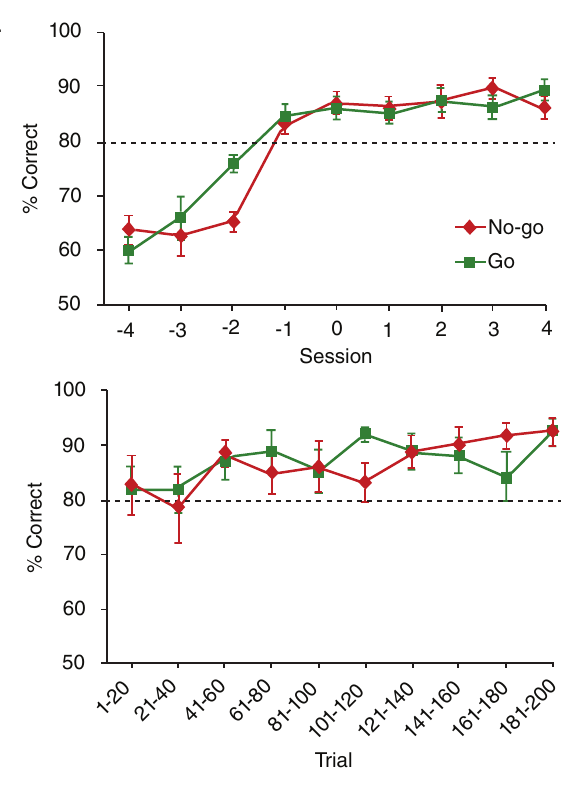
Figure 5. Stability of the task performance between ( A ) and within ( B ) sessions after reaching criteria. A . Session 0 represents the day when the rats (n=10) achieved the criteria (two consecutive training sessions with >80% (dashed horizontal grey line) correct challenge period responding). B . Within session challenge period responding for 200 trials, divided into 20 trial bins, is shown for the fourth training session after achieving criteria. Error bars indicate the standard error of the